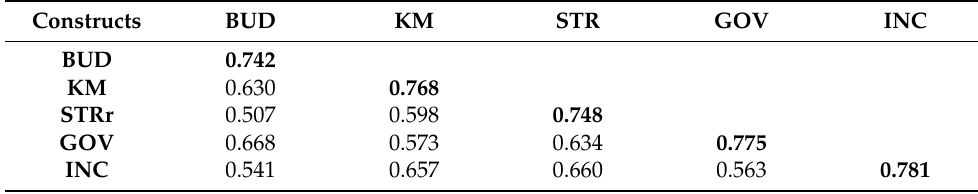
Table 3. Discriminant